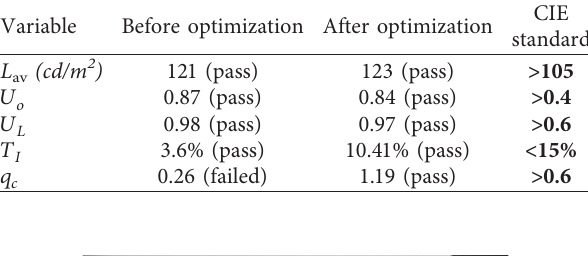
Figure 11: (a) The side view of the new counterbeam light after optimization; (b) the simulated intensity distribution of the optimized CBL with a 400W sodium lamp. Table 1: The comparison of lighting performance between the initially designed new CBL and the new optimized CBL for the tunnel threshold zone.